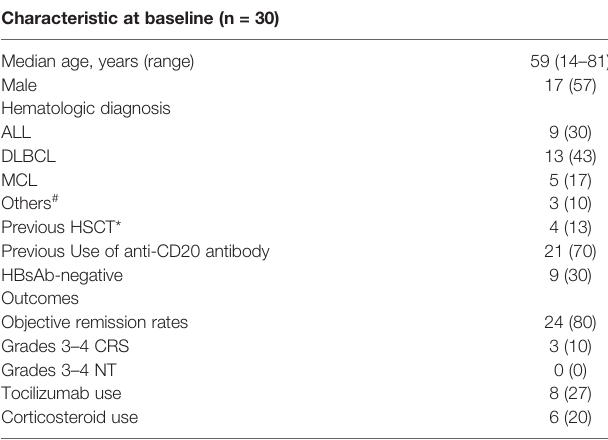
TABLE 1 | Baseline characteristics and responses to CAR T-cell therapy in the included patients. Characteristic at baseline (n =